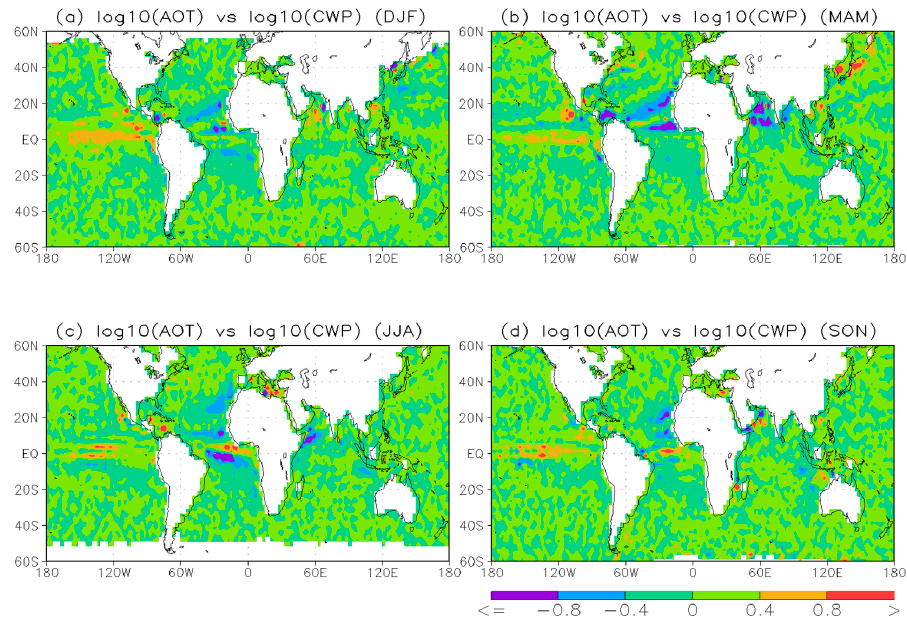
Figure 10. Similar to Figure 8 but shows the global maps of the linear correlation slope for log 10 ( AOT ) vs. log 10 ( CWP ) in four seasons: ( a ) DJF; ( b ) MAM; ( c ) JJA; and ( d ) SON.